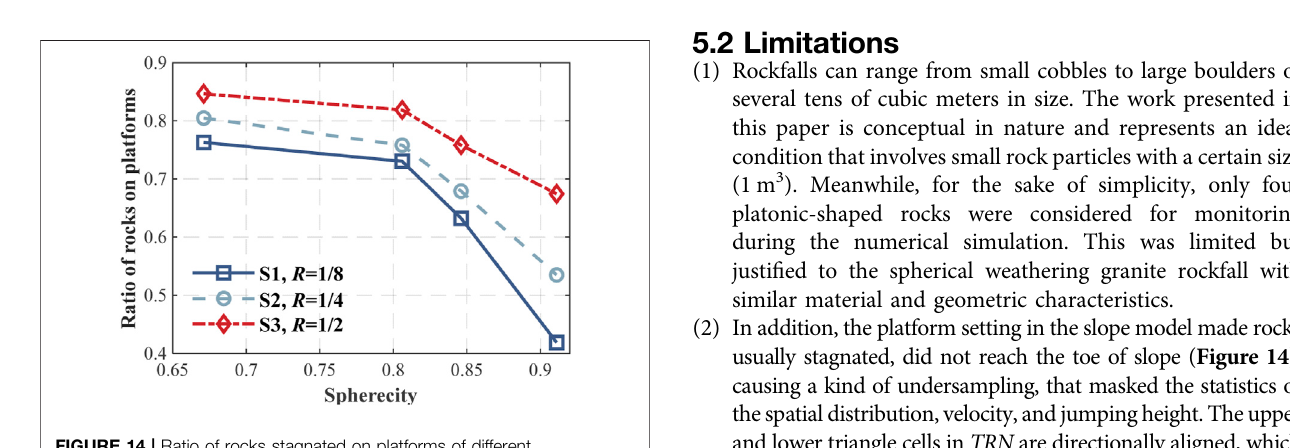
FIGURE 14 | Ratio of rocks stagnated on platforms of different roughness